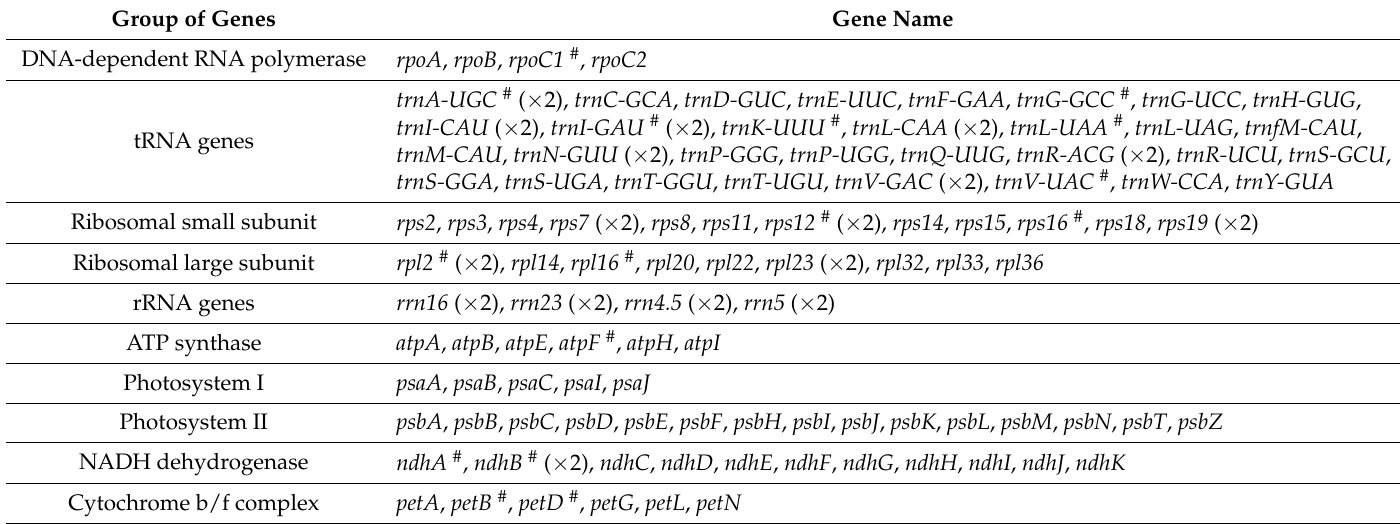
Table 2. Gene contents of the M. hupehensis chloroplast genome, based on genome annotation. Group of Genes Gene